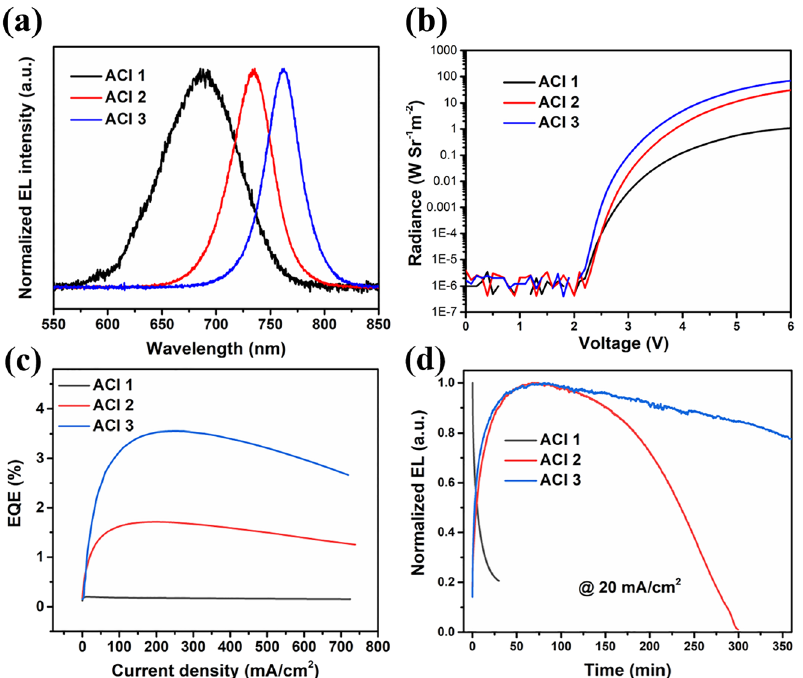
Figure6: (a)ELspectraoftheACIperovskites from the corresponding devices, (b) radiance versus voltage curves of LEDs based on ACI fi lms, (c) EQE versus current density characteristics of PeLEDs based on ACI fi lms, (d) Normalized EL intensity of device emitting layers under a constant current density of 20 mA cm − 2